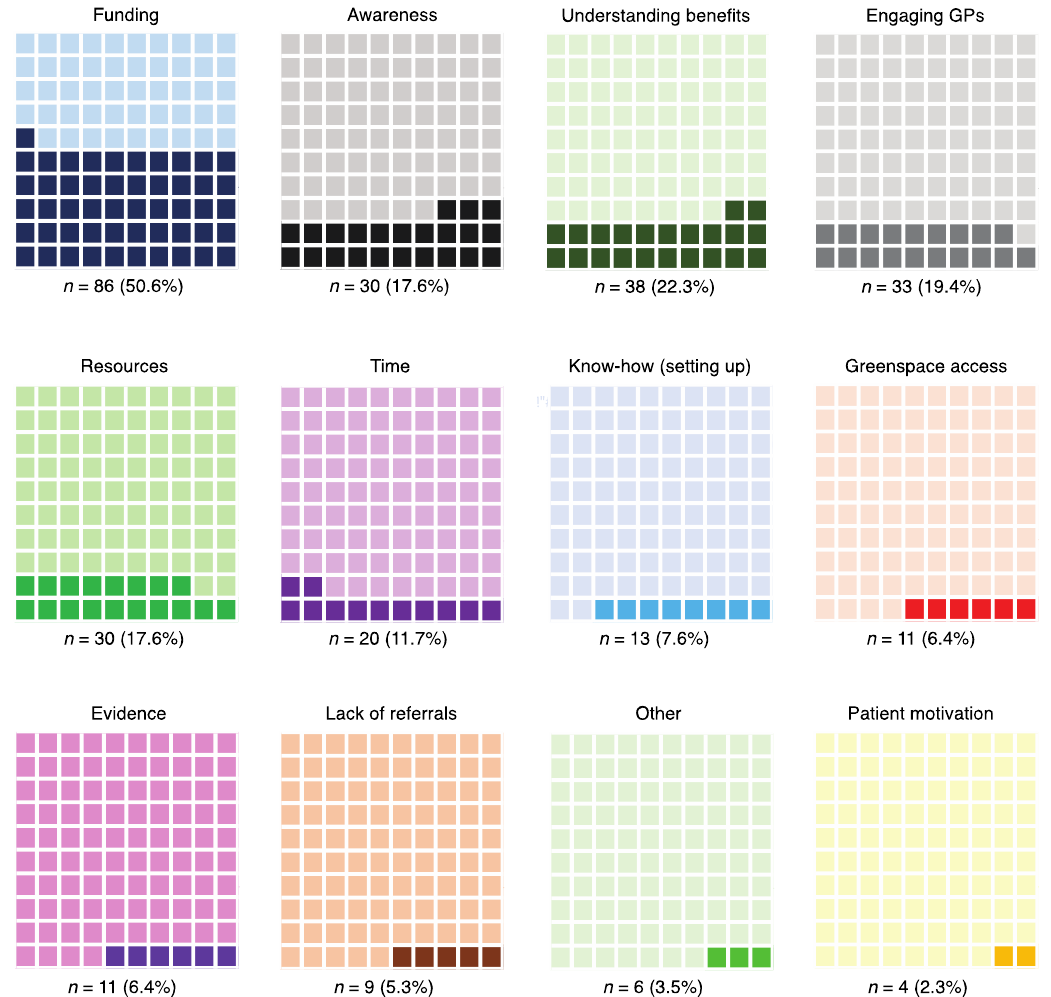
Figure 7. Waffle charts showing what nature-based organisations consider to be the key constraints to green prescribing. These charts show proportions with actual response counts and corresponding percentages below. The proportions are presented in descending order (i.e., of response frequency) from top left to bottom